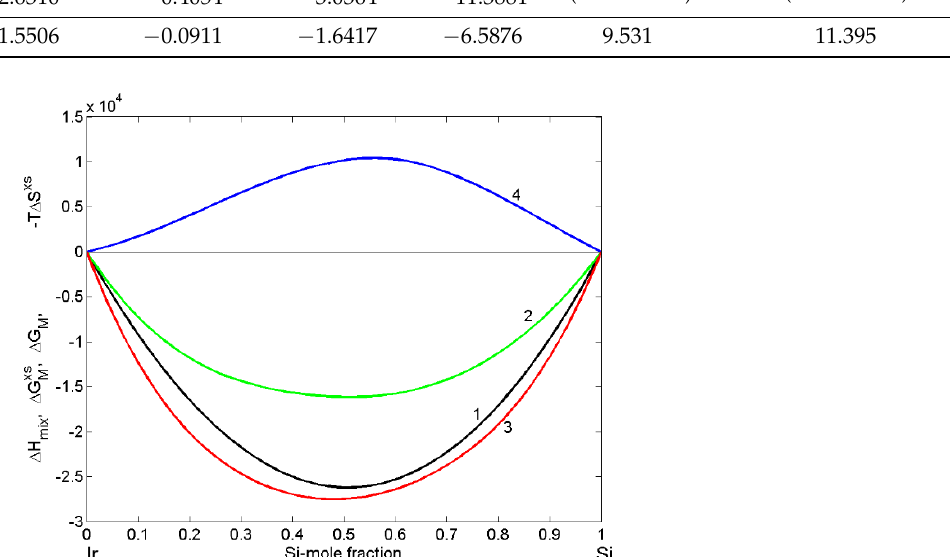
Figure 1. Concentration dependence of thermodynamic properties of liquid Ir-Si alloys calculated for T = 1873 K: 1-the enthalpy of mixing ( ∆ H M ); 2-the excess entropic term ( − T ∆ S xs ); 3-the excess Gibbs free energy ( ∆ G xs ); 4-the Gibbs free energy of mixing ( ∆ G M